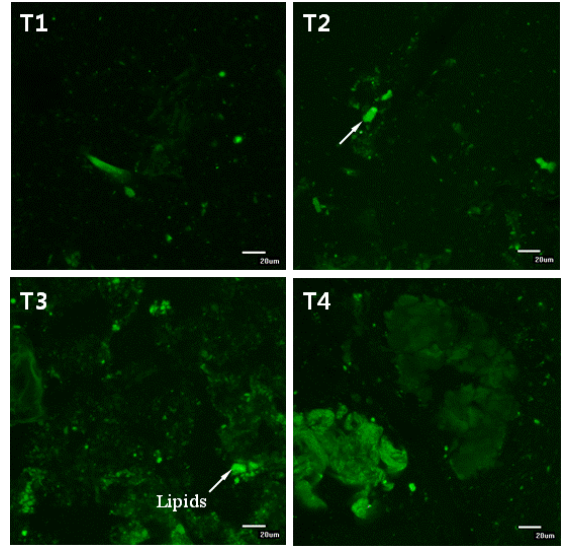
Figure 6. Confocal fluorescence images showing small intestinal contents after staining with Nile red. All green colored images represent stained